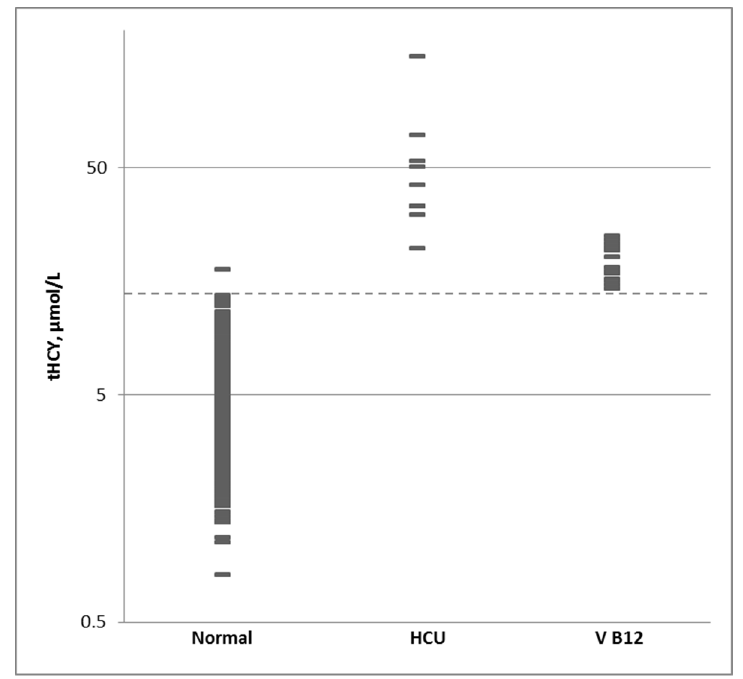
Figure 5. Distribution of tHCY results in a normal population (Normal, n = 1204), classical homocystinuria patients (HCU, n = 9), and patients with vitamin B12 deficiency (B12 def, n = 15). The dashed line represents the cutoff at 14 µmol/L.